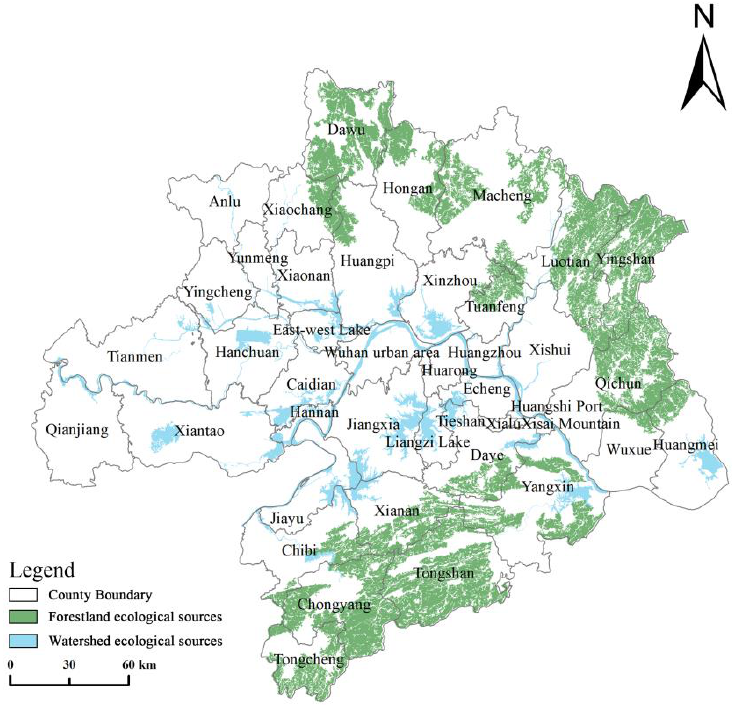
Figure 7. Ecological sources of WUA.